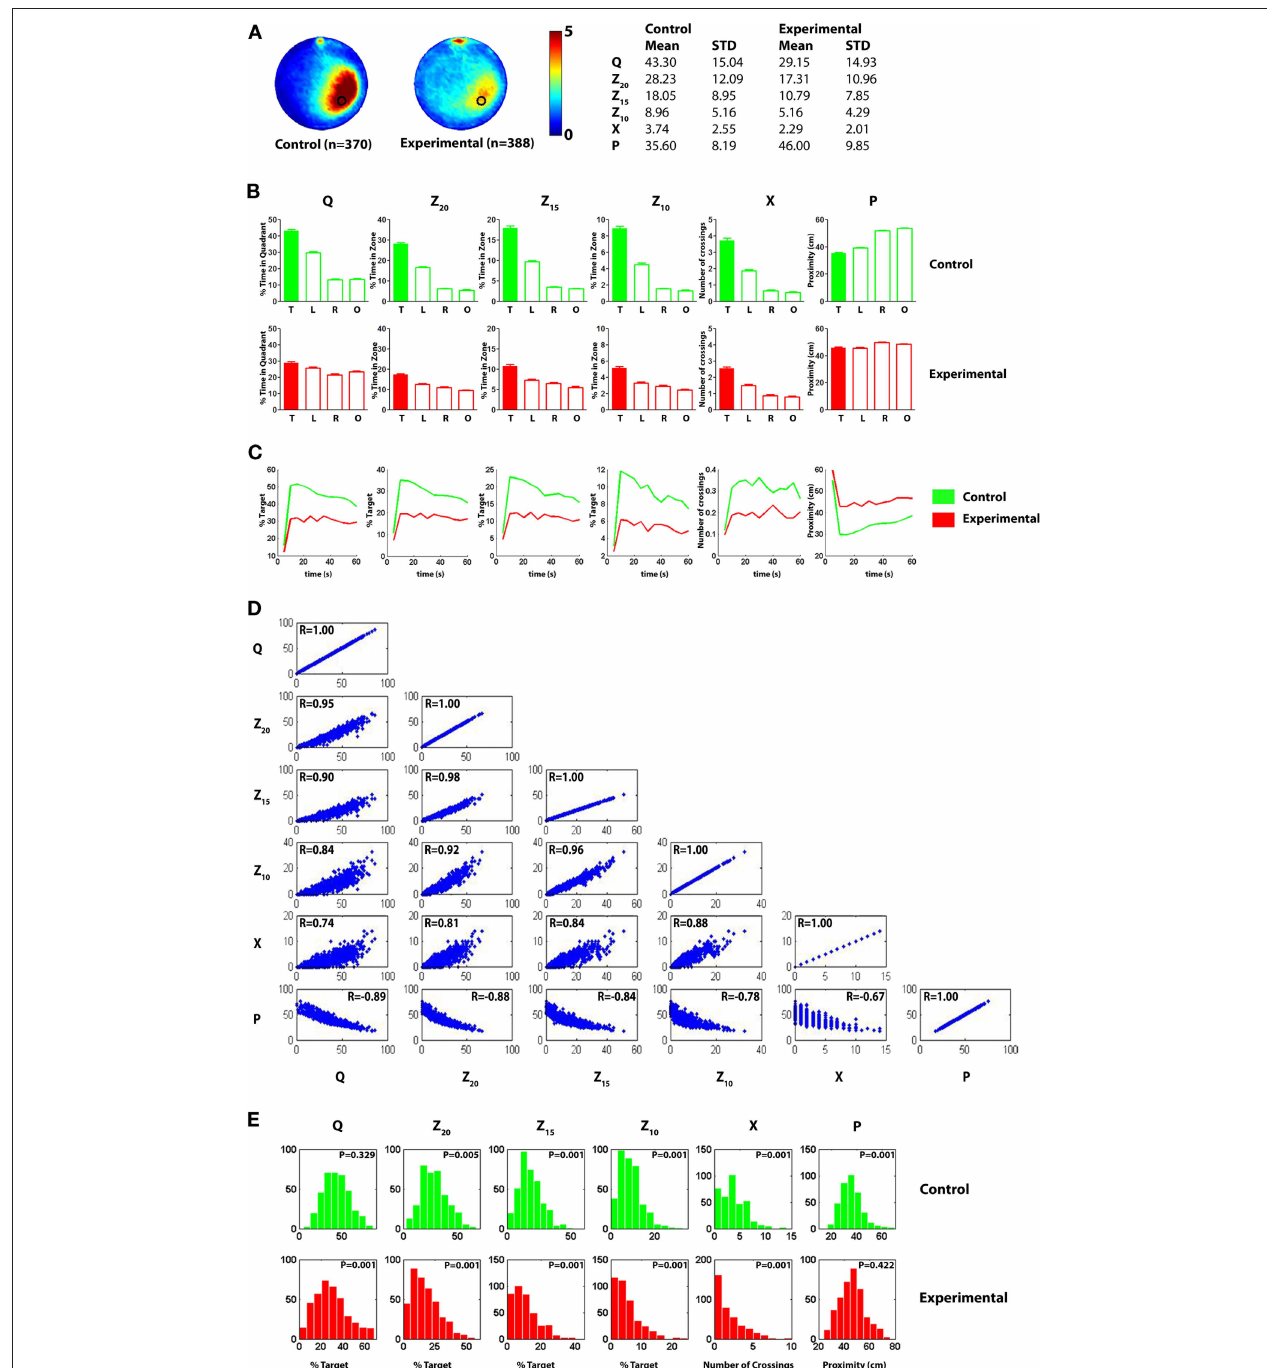
FIGURE 3 | Pooled probe test data for control and experimental mice for profi le of spatial bias across 60 s probe test for quadrant (Q), zone (Z analysis A. (A) Left, density plots for grouped data showing where control and Z ), crossing (X) and proximity (P) measures. Averaged data are shown in 5 s bins 10 experimental mice concentrated their searches in the probe test. The color scale for control (green) and experimental (red) datasets. (D) Scatterplots illustrating represents the mean number of visits per animal per 5 cm × 5 cm area. Right, how respective water maze measures correlate with one another for all 758 summary of descriptive statistics (mean values, standard deviations) for the probe tests included in the control and experimental datasets. Measures tended target quadrant (Q), zone (Z , Z and Z ), crossing (X) and proximity (P) to be highly correlated, with r -values range from 0.67 to 0.98 (all P -values < 0.01). 20 15 10 measures for control and experimental datasets. (B) Comparison of target (T) vs. (E) Distribution of probe test scores for control (upper; green) and experimental other pseudo-platform locations (right, R; left, L; opposite, O) for each measure (lower; red) datasets for each measure. According to the Lilliefors (Kolmogorov– (upper graphs show control data, lower graphs experimental data). (C) Temporal Smirnov) test, many distributions are positively skewed ( P -values <